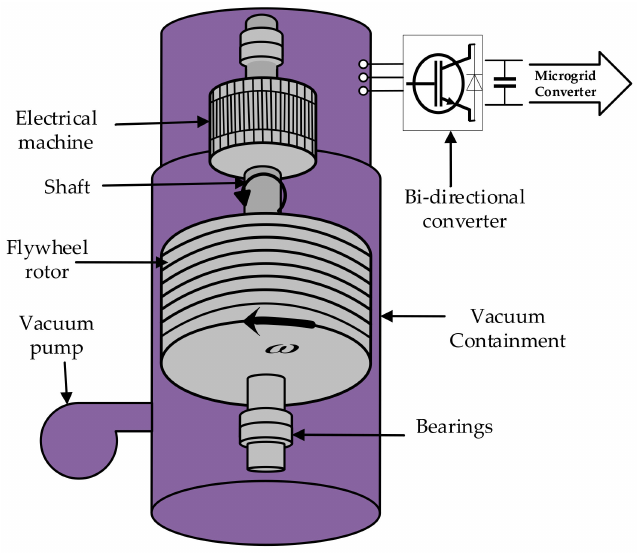
Figure 1. Structure of flywheel energy storage systems (FESS). The rotor of the flywheel with a rotating mass m (kg) having inertia J (kg · m 2 ) and spinning at an angular velocity of ω (rad/s), stores kinetic energy E (joules) as given by Equation (1).